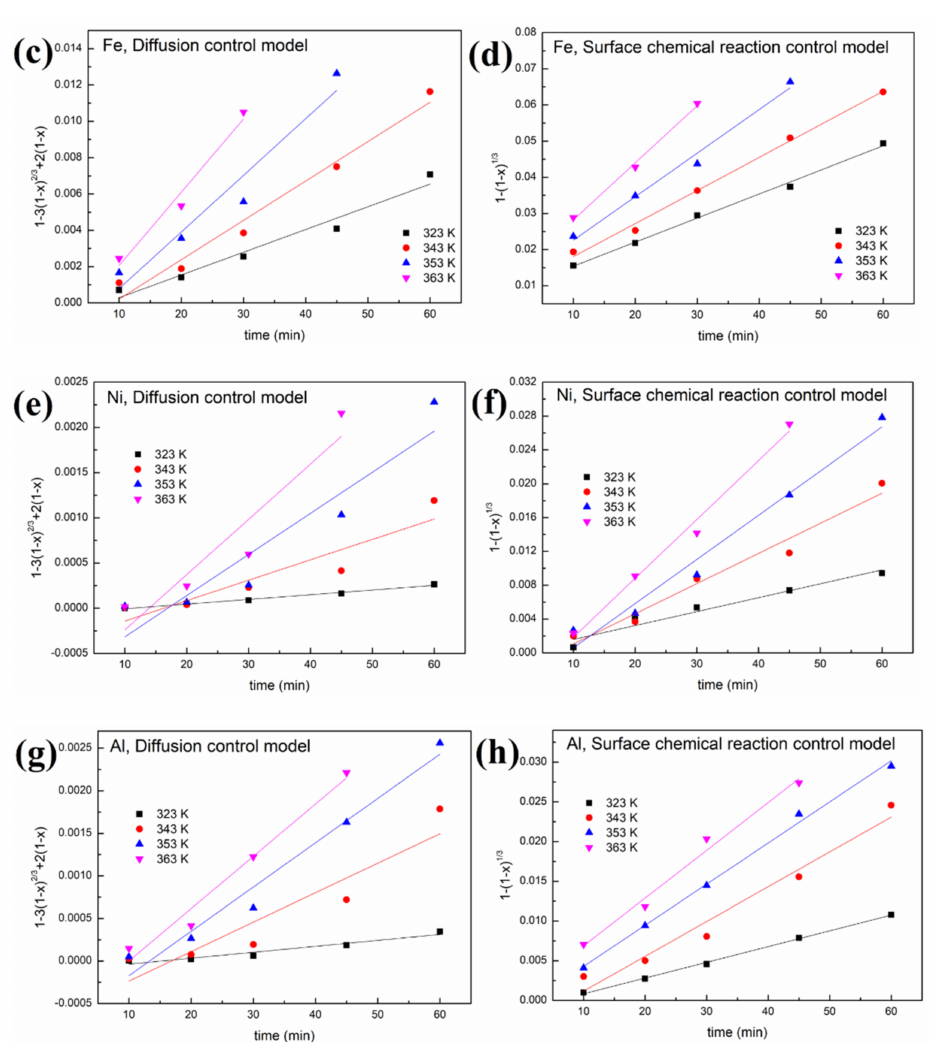
Figure 8. Leaching kinetics of different elements in oxalic acid: ( a ) V using the diffusion control model; ( b ) V using the surface chemical reaction control model; ( c ) Fe using the diffusion control model; ( d ) Fe using the surface chemical reaction control model; ( e ) Ni using the diffusion control model; ( f ) Ni using the surface chemical reaction control model; ( g ) Al using the diffusion control model; ( h ) Al using the surface chemical reaction control model.